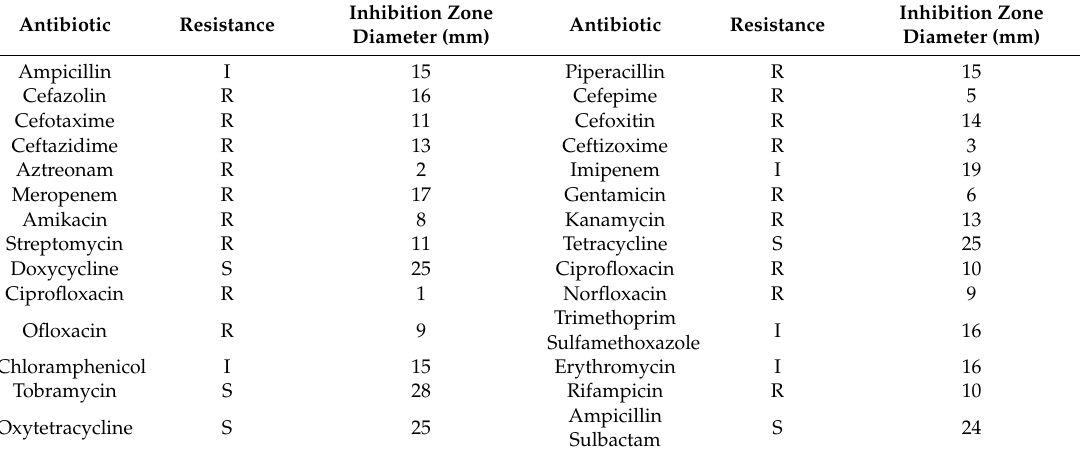
Table 1. Results of the antibiotic susceptibility test using the disk diffusion method. Antibiotic